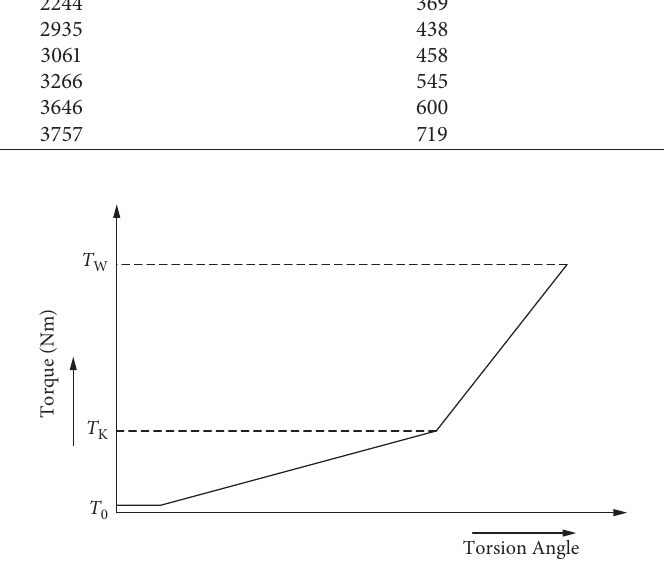
Figure 19: Optimization schematic of torsional characteristic